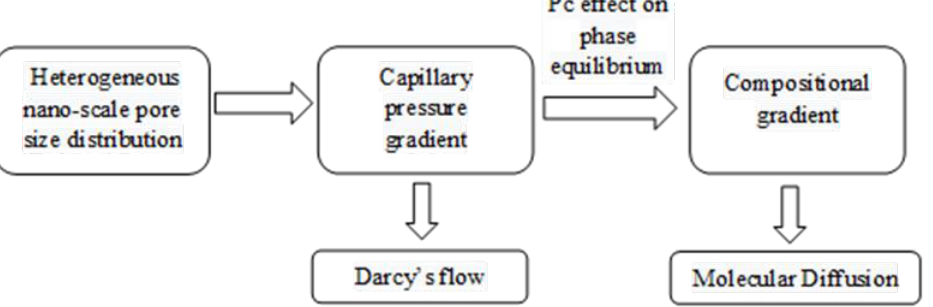
Figure 4. Effect of heterogeneous nano-scale pore size distribution on fluid flow mechanisms.